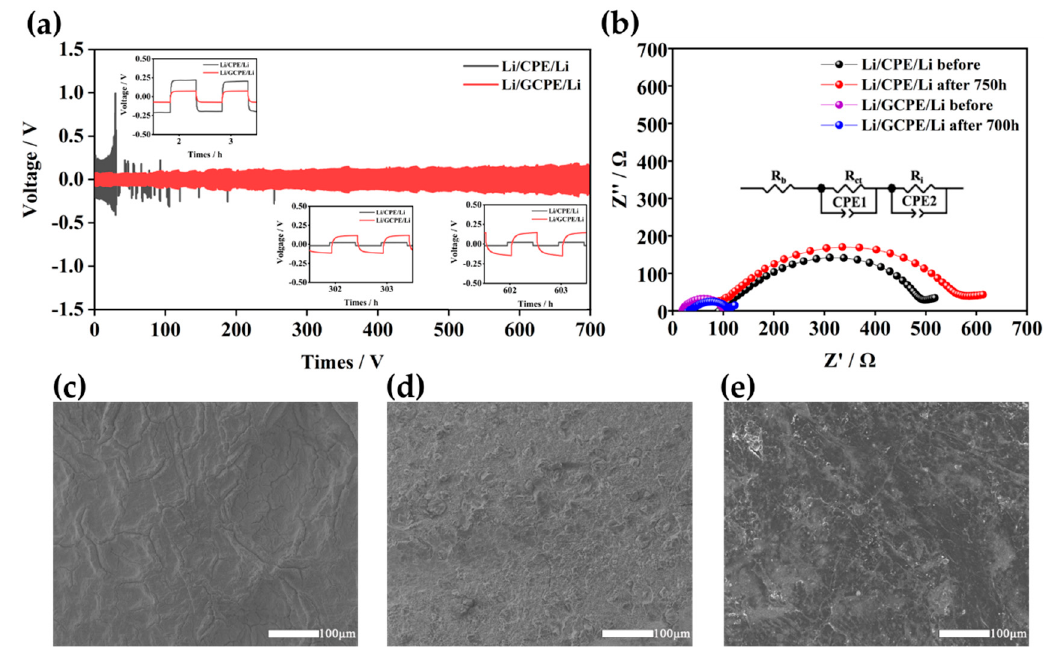
Figure 4. ( a ) Li/CPE/Li symmetric cells and Li/GCPE/Li symmetric cells were tested at 0.2 mA/cm − 2 for 700 h. ( b ) EIS of Li/CPE/Li and Li/GCPE/Li. ( c − e ) SEM of fresh lithium metal and metallic lithium in Li/CPE/Li and metallic lithium in Li/GCPE/Li after 700